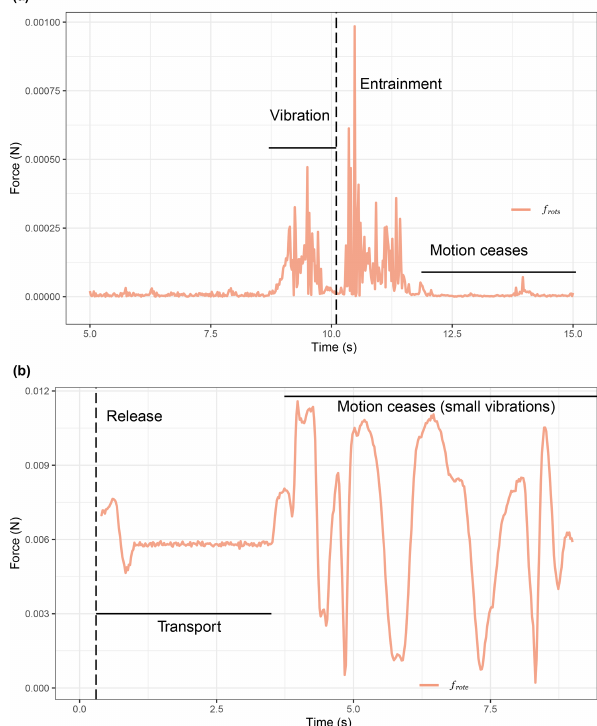
Figure C1. Force magnitude of the rotational component. (a) Flume experiment (incipient motion) using the spherical sen- sor (Fig. 3a). (b) Field experiment (Erlenbach) using the ellipsoid sensor (Fig. 3e). The differences between the linear and the rota- tional components are between 1 and 2 orders of magnitude. f rot is of the order of 10 − 3 to 10 − 2 N (sphere in the flume and ellipsoid in Erlenbach, respectively), while the linear forces (applied directly on the centre of the mass of the particle) are of the order of 10 0 to 10 1 N (Appendix